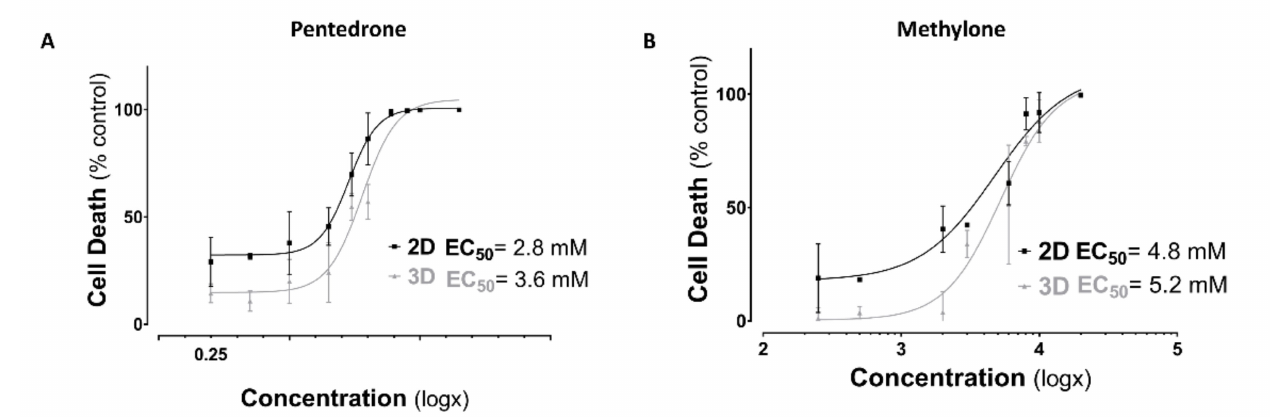
Figure 3. Nonlinear regression models of dose–response curves in 2D and 3D HLCs cells 24 h after exposure to ( A ) pentedrone and ( B ) methylone (0–20.0 mM) racemates. Data are presented as mean ± SD. Concentration–response curves were fitted using least squares as the fitting method and the comparisons between curves were made using the extra sum-of-squares F test. Results were obtained from three independent experiments, performed in